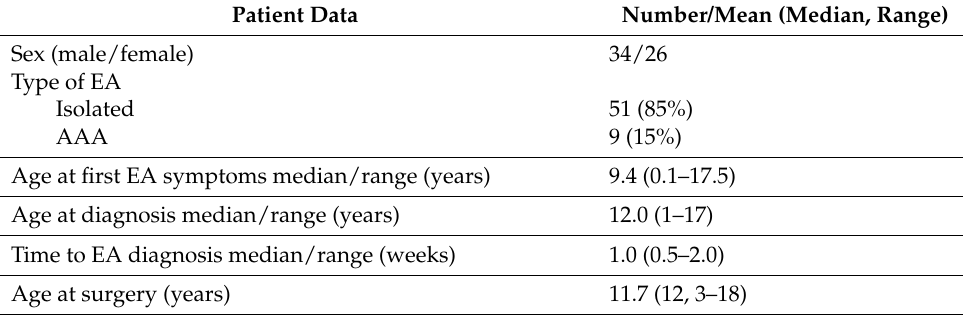
Table 2. Demographics, clinical presentation, and diagnostic